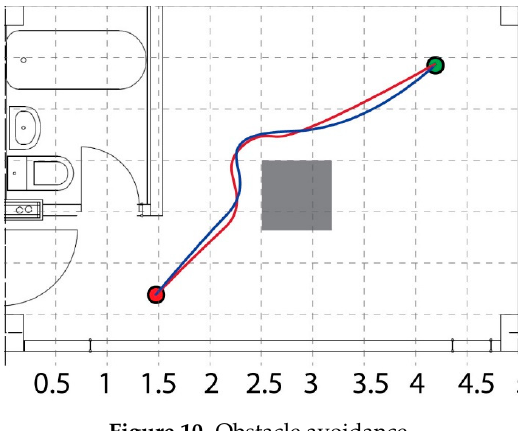
Figure 10. Obstacle avoidance.